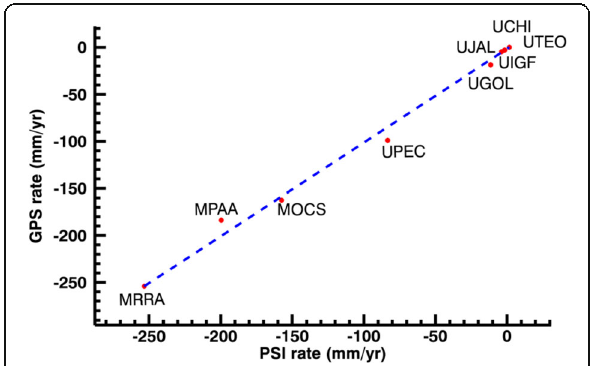
Fig. 10 GPS and PSI comparison in the Mexico City study area from Table 2. The dashed line is 1-to-1 line shows a great correlation between the GPS and PSI data. R^2 is in the range of